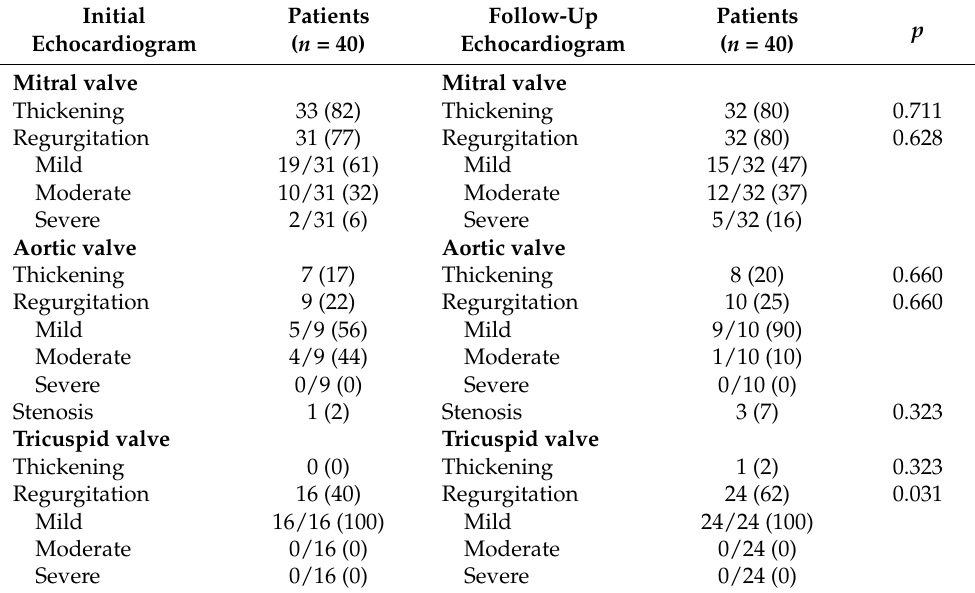
Table 5. Comparison of heart valve involvement between first and last